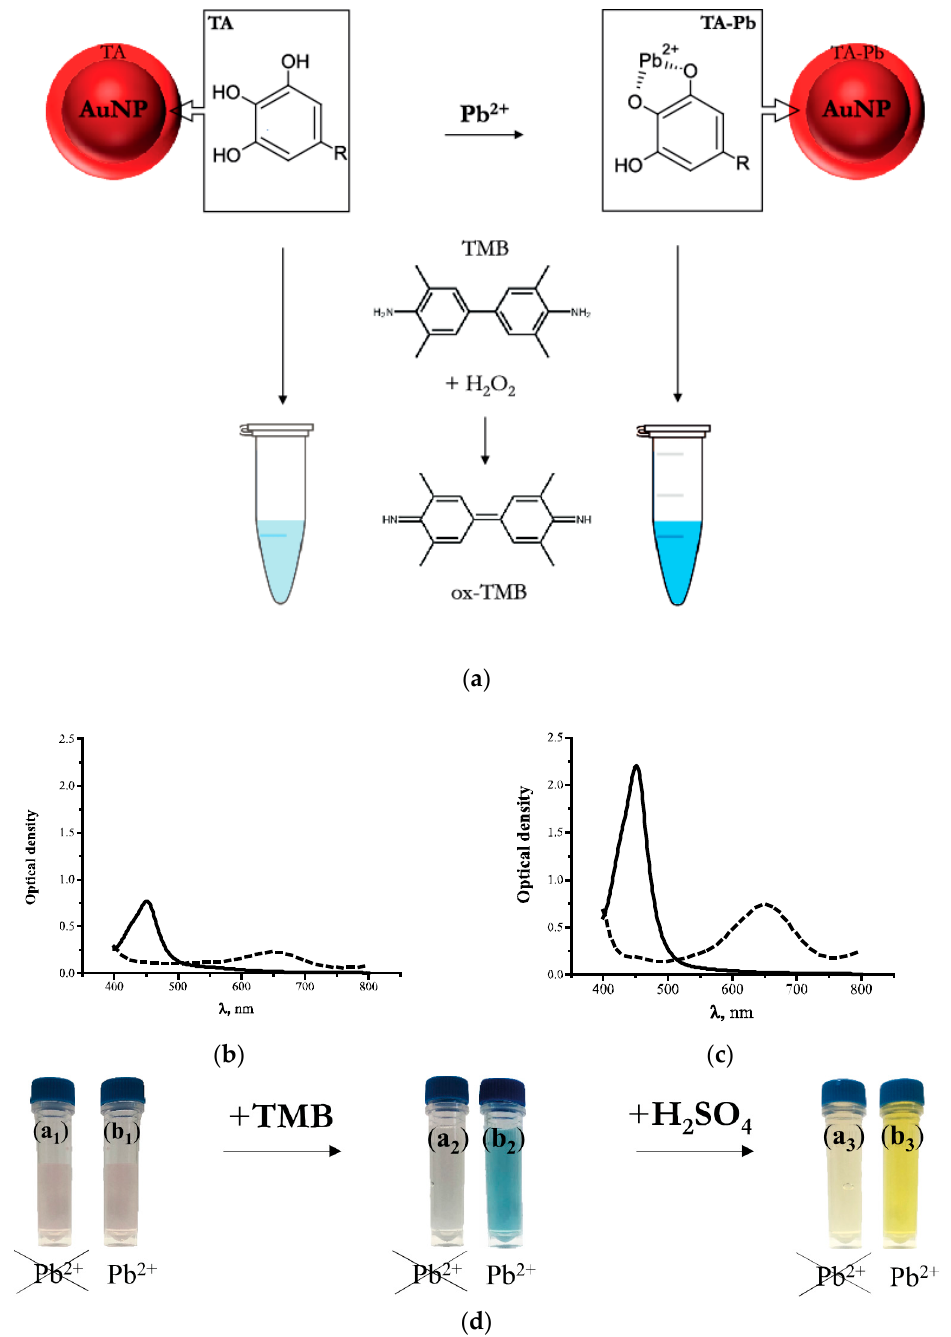
Figure 2. Principle of the TA-capped AuNPs based colorimetric sensor for Pb 2+ detection. ( a ) Scheme of catalytic oxidation of TMB in presence of AuNPs. ( b ) Absorbance spectra of TA-capped AuNPs without and with ( c ) Pb 2+ ions after addition of TMB-H 2 O 2 (dash lines) and stop reaction (solid lines) respectively. ( d ) Corresponding photographs of TA-capped AuNPs samples before/after catalytic reaction in the presence/absence Pb 2+ ions.